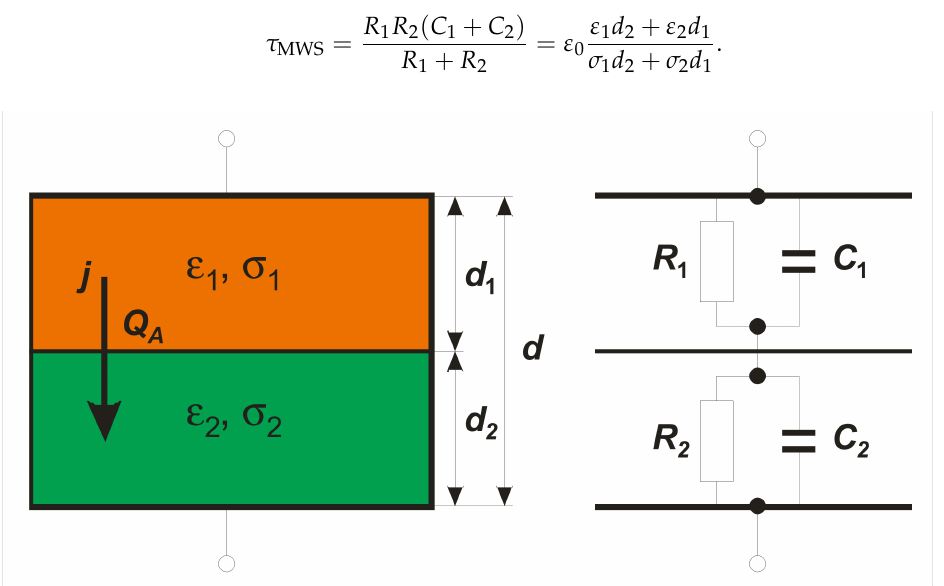
Figure 1. Scheme of two-layer condenser ( left ) and its equivalent circuit ( right